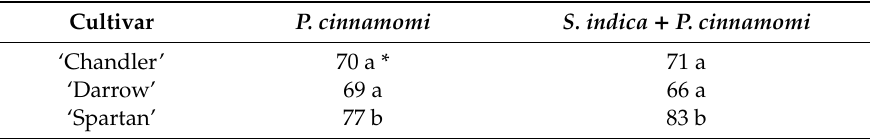
Table 3. Re-isolation of P. cinnamomi from substrates inoculated with P. cinnamomi on which blueberry plants were grown. Re-isolation was made by baiting on leaves of rhododendron (RH) and highbush blueberry (HB); success ( + ); lack ( − ). Control Cultivar HB RH HB RH HB RH HB RH HB ‘Chandler’ − − + − + − − − + − + − ‘Darrow’ − − + − + − − − + − + − ‘Spartan’ − − + + + + − − + + + + Table 4. Mean number of necrotic spots per baitrhododendron leaf ‘Nova Zembla’, ( n = 10) re-isolated from substrates on which highbush blueberry was